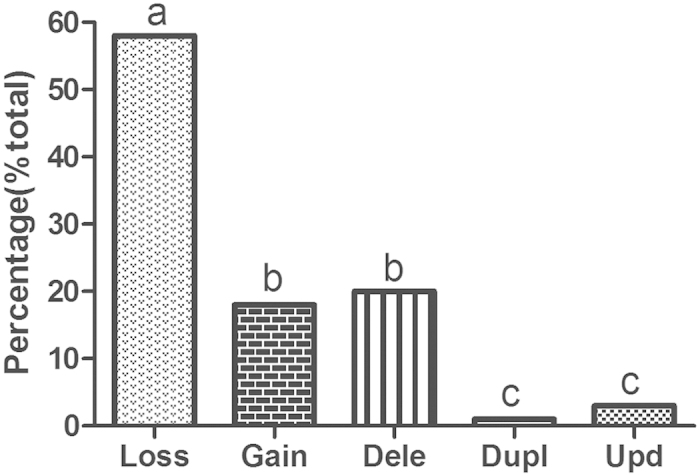
Analysis of abnormal SNP array signals.Frequently-detected abnormal signals following SNP array-based chromosome analysis were analyzed by dividing the number of distinct signals by the number of abnormal signals. “Loss”, lack of an entire chromosome; “Gain”, an increase in the number of copies of a chromosome; “Dele”, segmental chromosome deletion; “Dupl”, segmental chromosome duplication; “Upd”, uniparental disomy. Different alphabets on the histogram indicate significant differences (P < 0.05).